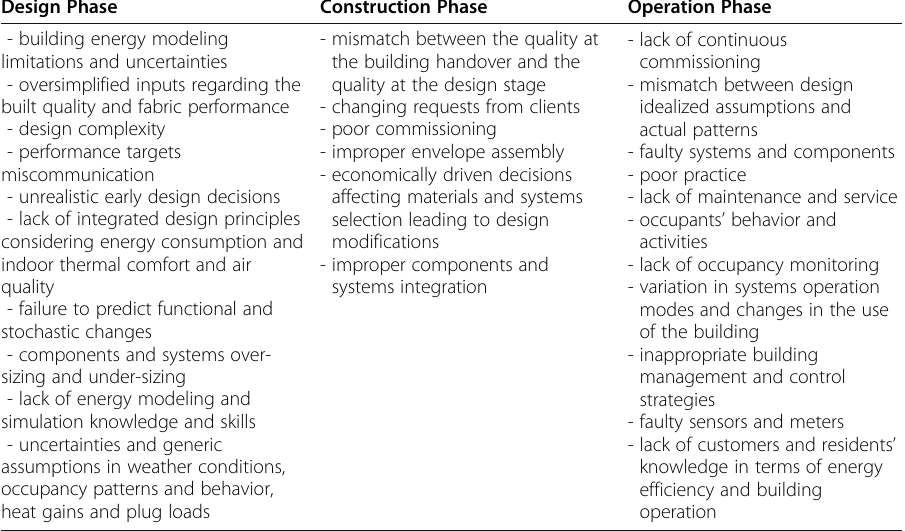
Table 1 Causes of energy performance gaps in buildings (Jradi et al., 2018) Design